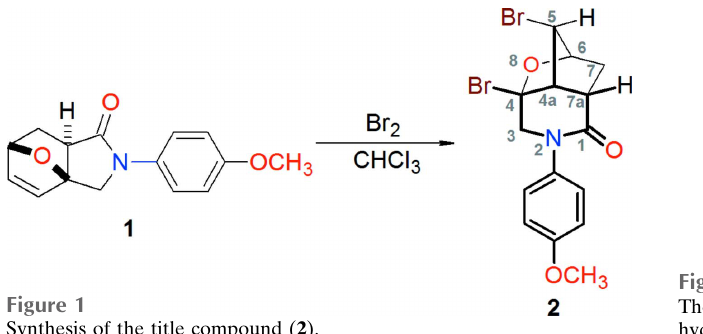
Figure 1 Synthesis of the title compound ( 2